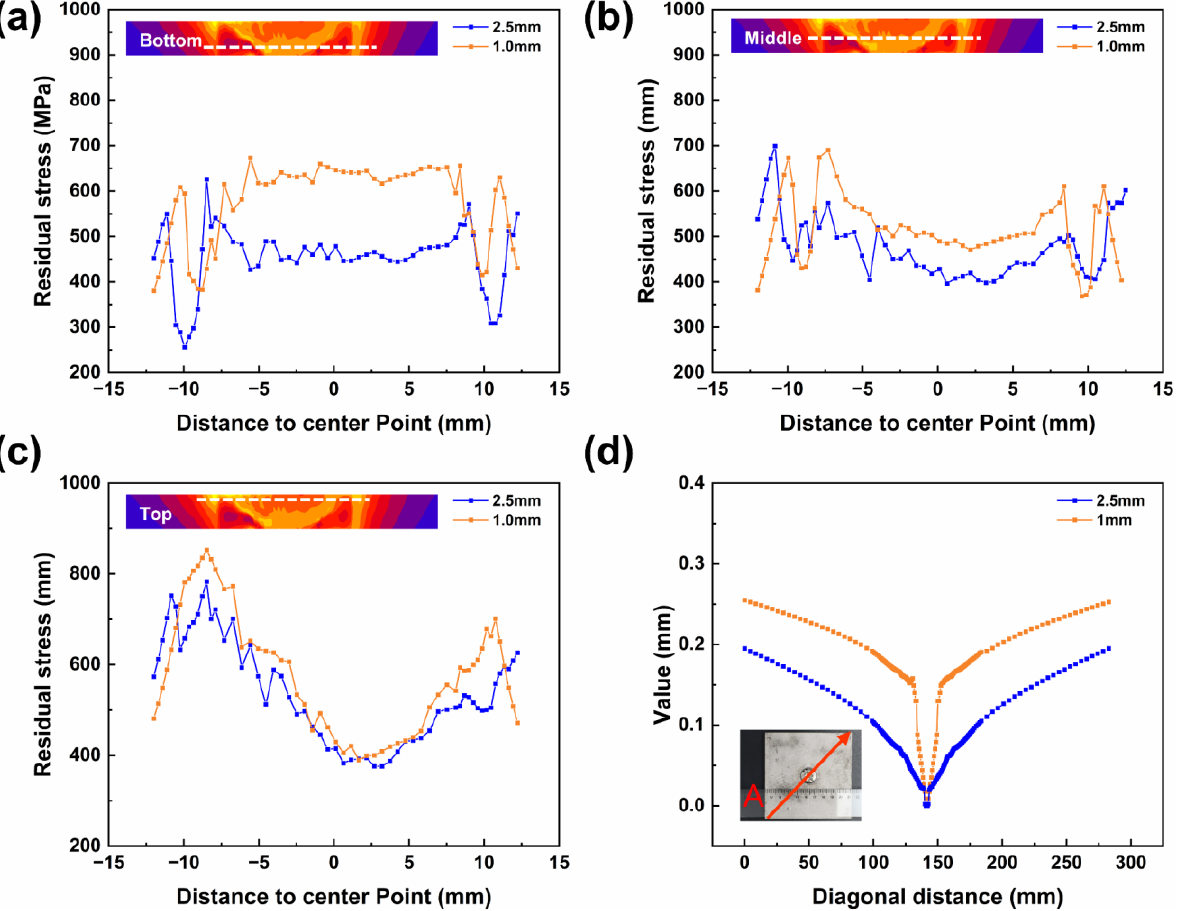
Figure 12. Comparison of residual stress and deflect deformation along different regions: ( a ) Bottom layer, ( b ) Middle layer, ( c ) Top layer, ( d ) Deflect deformation along Diagonal.